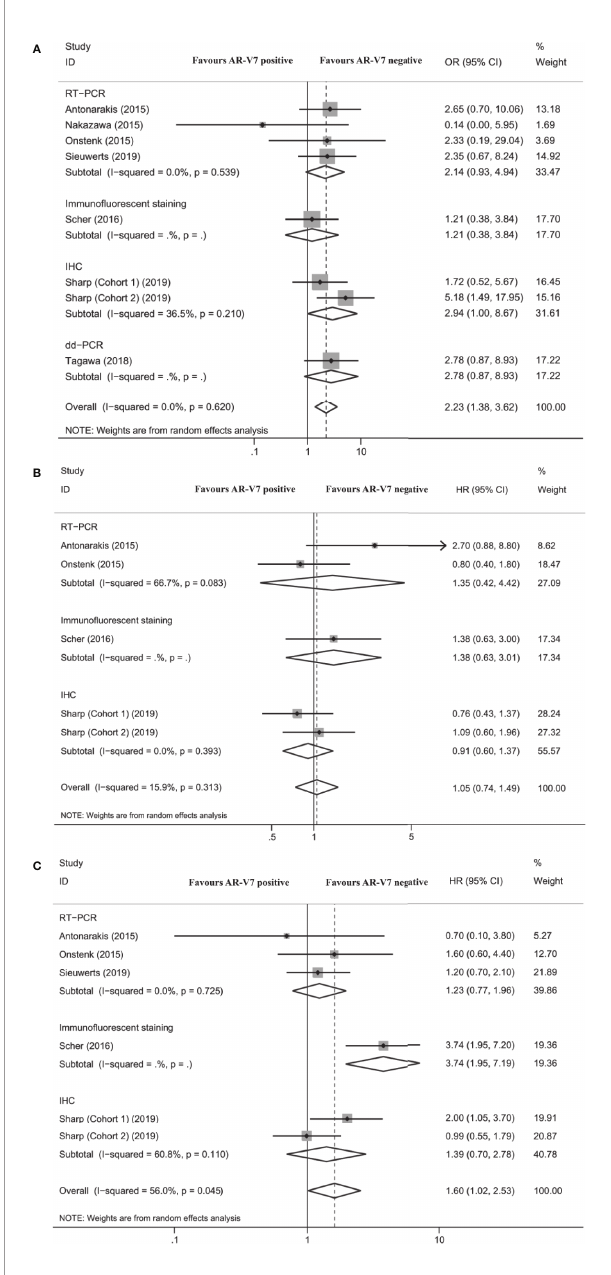
FIGURE 3 | Forest plot of mCRPC patients treated with chemotherapy with different AR-V7 status. (A) prostate-speci fi c antigen (PSA) response rate; (B) progression free survival (PFS); and (C) overall survival (OS). AR-V7, androgen receptor splice variant 7; OR, odds ratio; CI, con fi dence interval; RT-PCR, reverse transcriptase-polymerase chain reaction; IHC, immunohistochemistry; dd-PCR, digital-droplet polymerase chain reaction; HR, hazard